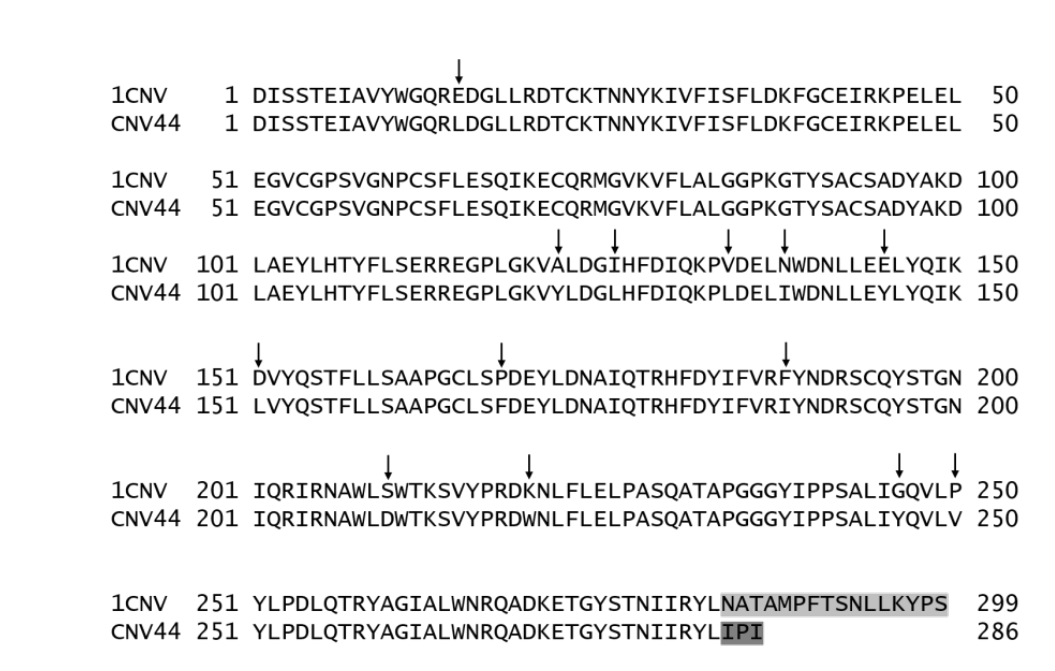
Figure 2. Sequences of Concanavalin B scaffold (1CNV) and Modified Concanavalin (CNV44). Arrows indicate substitution sites. The deleted C-terminal sequence as well as the dipeptidyl peptidase IV (DPPIV) inhibitor that replaces it (IPI) are shown in light gray.